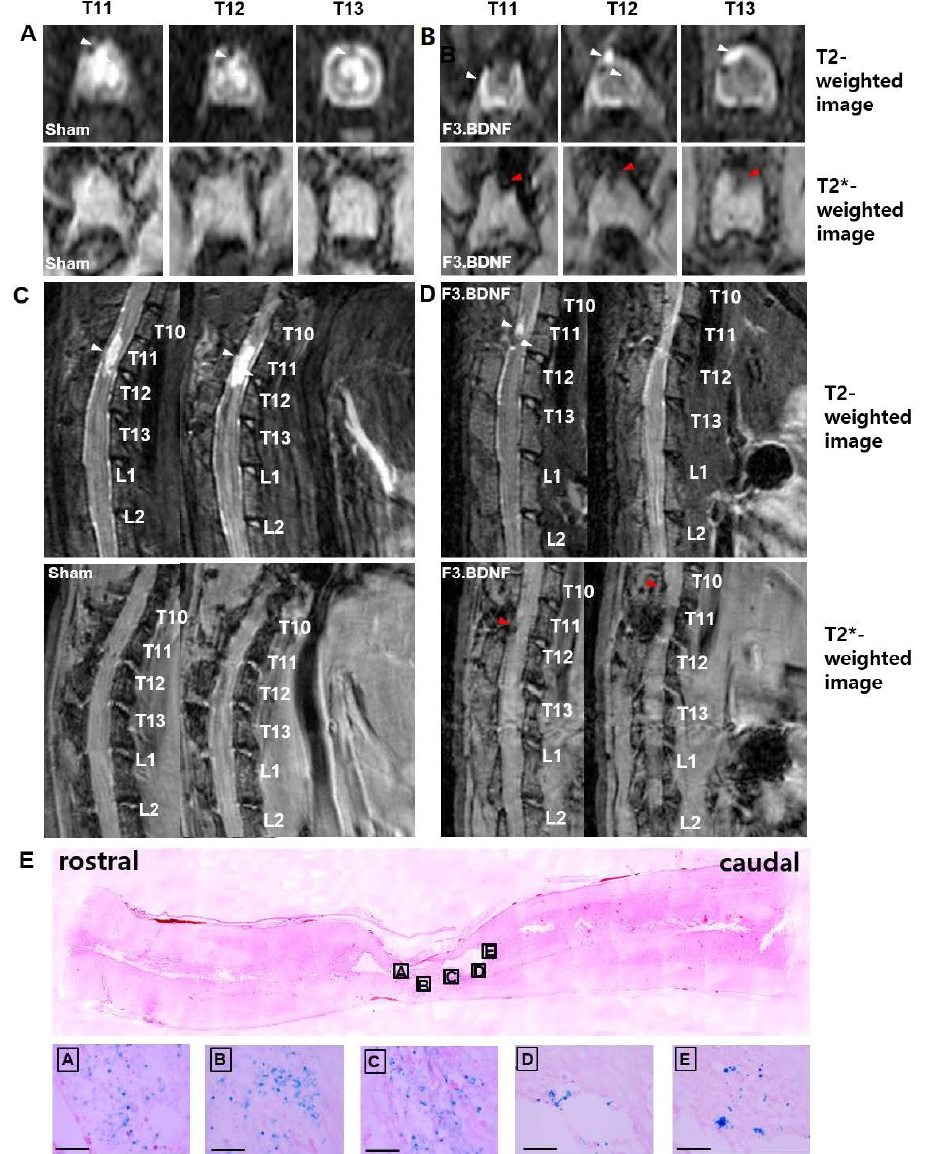
Figure 1. Detection of Feridex ® -labeled F3.BDNF cells on MR images. ( A , C ) Sham group, ( B , D ) F3.BDNF group ( n = 3 each). T2-weighted MR image on the top line in ( A , B ) and T2 *- weighted MR image on the bottom line in ( A , B ) at 72 days after spinal cord injury. The red arrowhead indicates the migrating Feridex ® -labeled F3.BDNF cells toward the contusive injured spinal cord at the T11, T12, and T13 of axial levels and T10 and T11 of sagittal T2 *-weighted MR images. The white arrowhead indicates the contused spinal cord area. The hyperintense lesions in T2-weighted MR images at 72 days after spinal cord injury showed a significant difference between F3.BDNF group and sham group. ( E ) Histological distribution of labeled F3.BDNF after transplantation. Prussian blue staining shows that labeled F3.BDNF cells were migrated away from the injection site and dispersed throughout the injured spinal cord. Scale bar: 100 µ